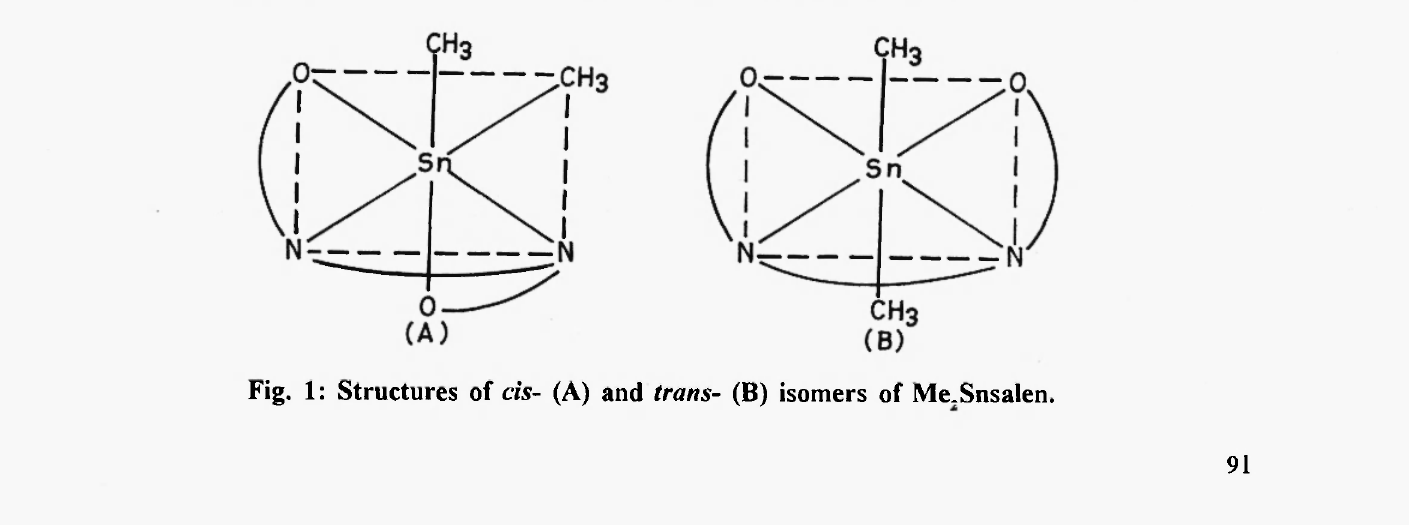
Fig. 1: Structures of cis- (A) and trans- (B) isomers of Me